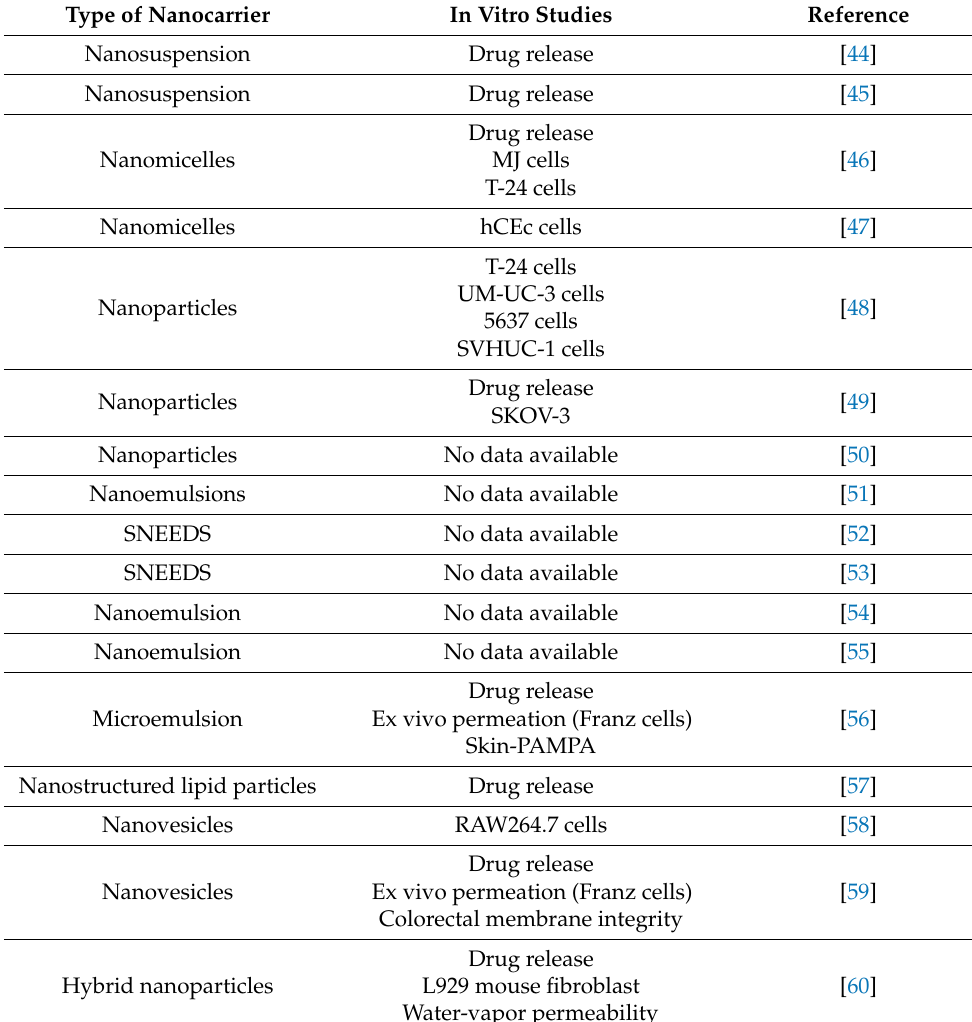
Table 2. In vitro studies of the developed nanocarriers loaded with